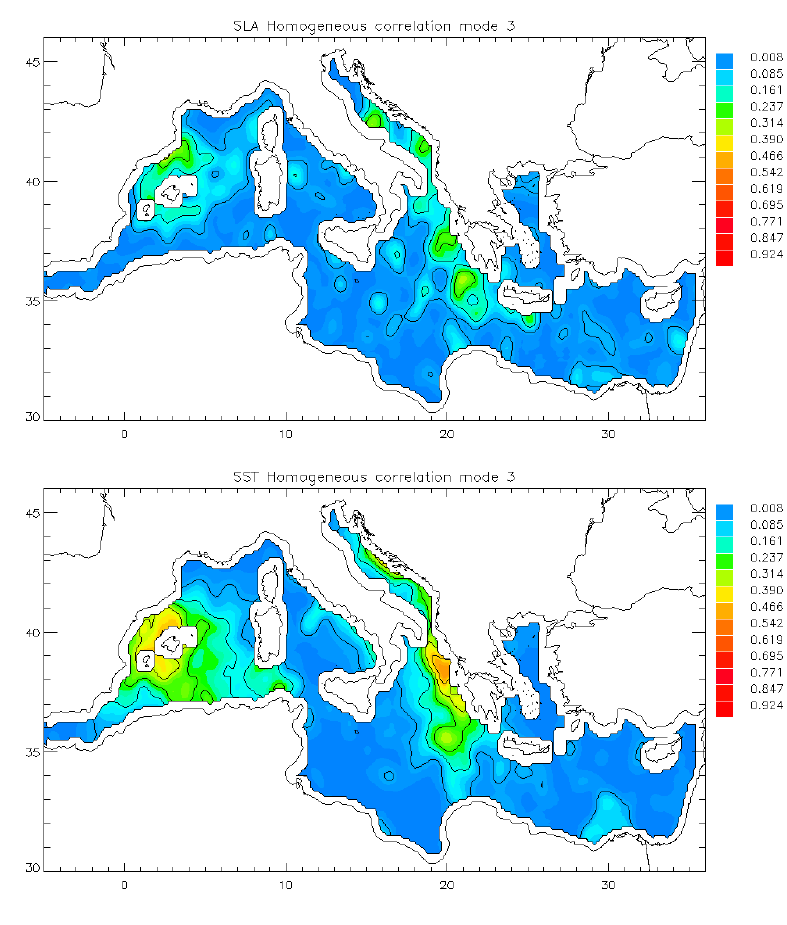
Fig. 10. SLA (a) and SSTA (b) homogeneous correlation maps relative to the third “gradient CPA” mode.